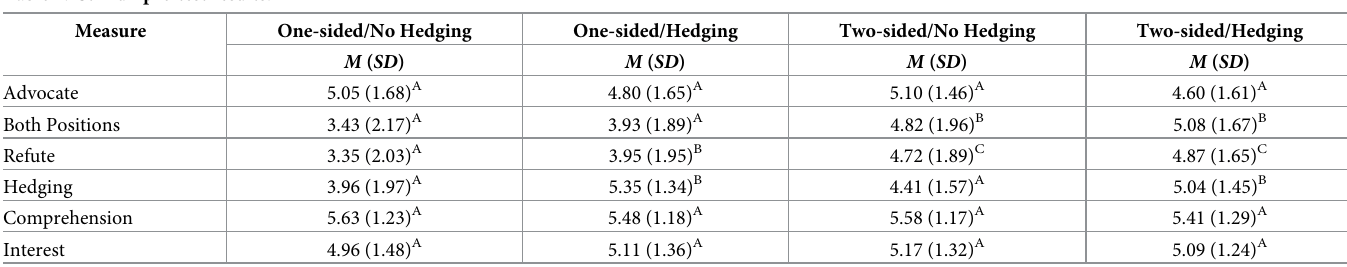
Table 1. Stimuli pre-test